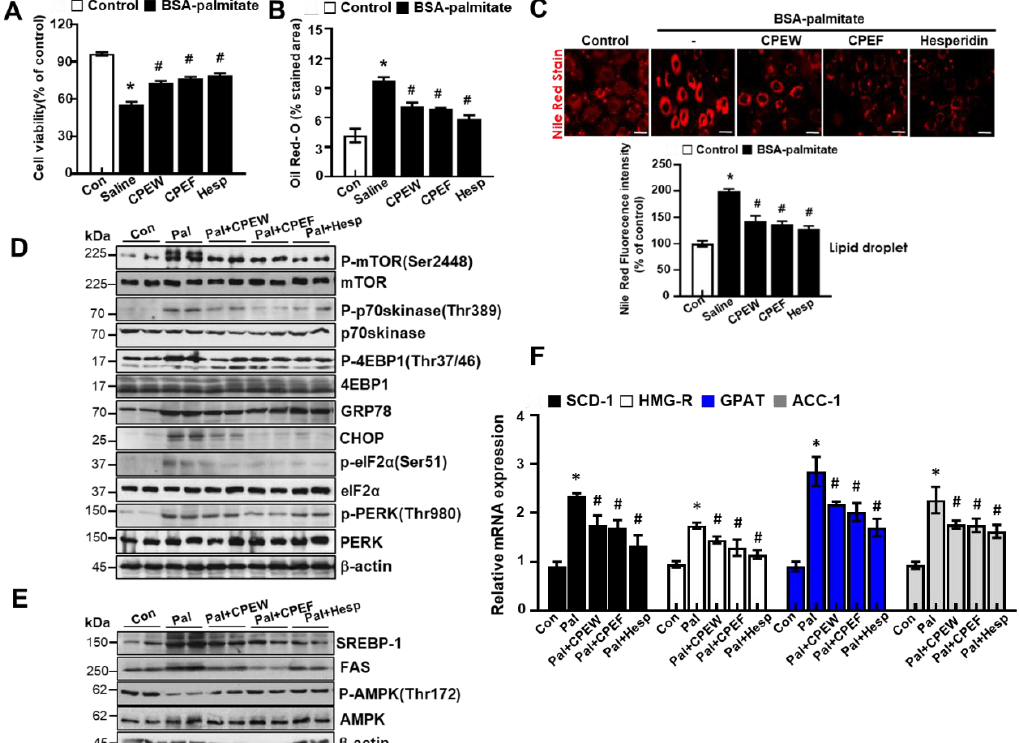
Figure 9. The major components of citrus peel regulate palmitate-induced steatosis in AML cells. ( A ) AML12 cells were treated with 100 μg/mL CPEW, 100μg/mL CPEF or 50 μM hesperidin or 24 h for the indicated periods, and cytotoxicity was determined using the MTT assay. ( B ) Oil-Red-O stain for lipid content staining was measured in palmitate-treated cells. ( C ) Nile Red stain for lipid content staining was measured in palmitate-treated cells. AML12 cells were treated with 100 μg/mL CPEW, 100 μg/mL CPEF, or 50 μM hesperidin for indicated periods, and the expression of proteins of interest was determined by western blotting. ( D ) Immunoblotting was performed using antibodies against p- mTOR, mTOR, p-p70S6K, p70S6K, GRP78, CHOP, p-PERK, PERK, p-eIF2α, eIF2α, and β-actin. ( E ) Immunoblotting was performed using antibodies against SREBP-1, FAS, p-AMPK, AMPK and β- actin. ( F ) mRNA expression levels including stearoyl-CoA desaturase-1 (SCD-1), 3-hydroxy-3- methylglutaryl CoA reductase (HMG-R), glycerol 3-phosphate acyltransferase (GPAT), and acetyl- coenzyme A carboxylase (ACC) was measured. Results are mean ± SEM from 3 separate experiments. ( * P < 0.05 vs. control, # P < 0.05 vs. palmitate). CPEW, citrus peel extract hot-air dry; CPEF, citrus peel extract freeze-drying.*.